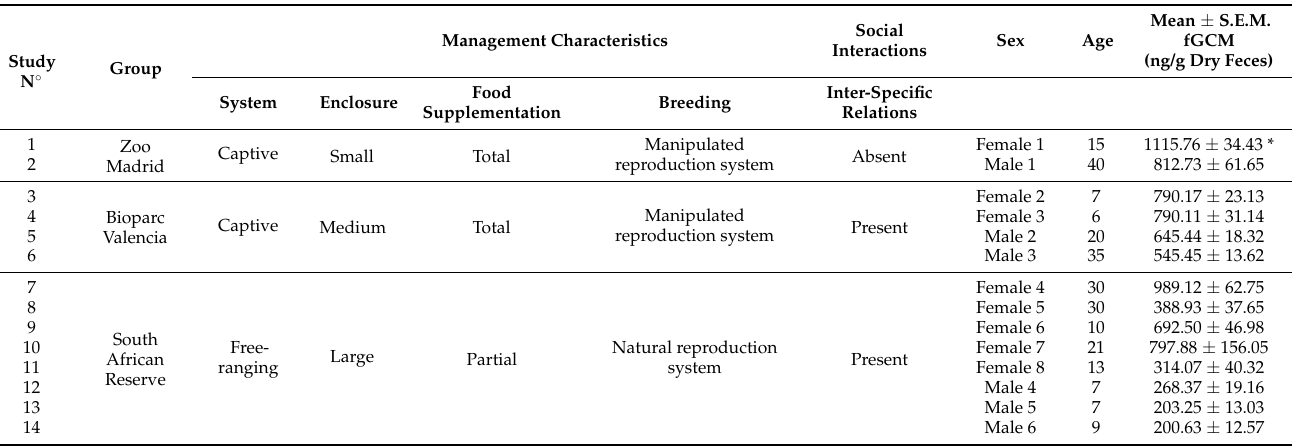
Table 1. Details of management characteristics, social interactions, sex, age (years) and fecal glucocorticoid metabolite concentrations (fGCM) ± standard error of the mean (S.E.M.) determined by EIA in the fourteen white rhinoceroses included in the study.